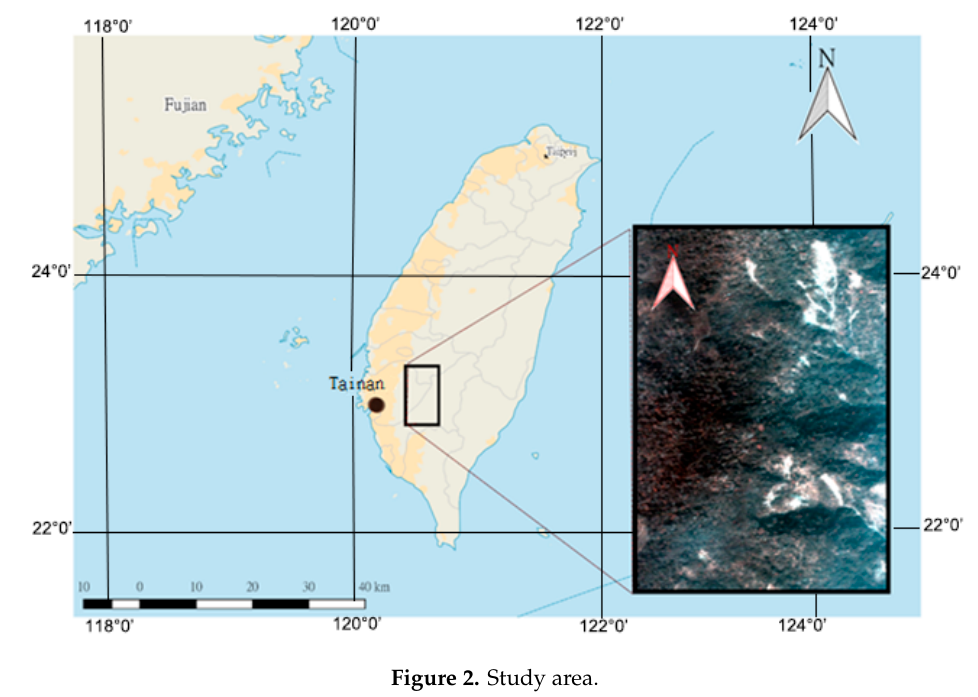
Figure 2. Study area.